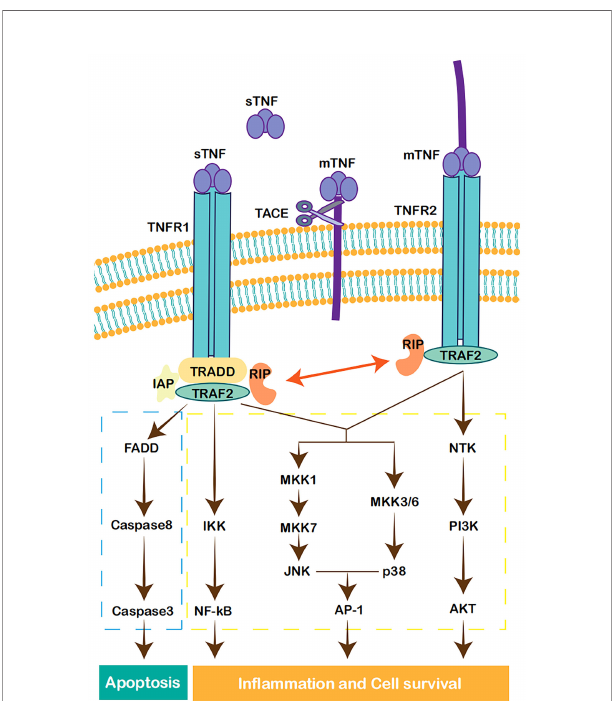
FIGURE 1 | Cell signaling pathways activated by TNF. TNFR1 forms a complex with TRADD, TRAF2, RIP, and IAP, leading to the activation of NF- k B (17). JNK and p38MAPK are also in the downstream of TNFR1 and TRAF2, leading to the activation of AP-1 and other transcription factors (21). The recruitment of TRADD, FADD, and caspase-8, activates caspase-3, which in turn induces apoptosis (22). TNFR2 can also activate MAPK and NF- k B pathways (17, 21). TNFR2 can also realize signal transduction through PI3K/Akt-dependent pathway